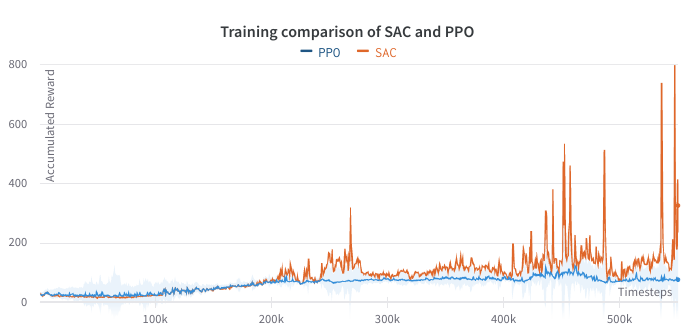
Figure 13. Comparison of accumulated reward for the decentralized single-agent SAC and